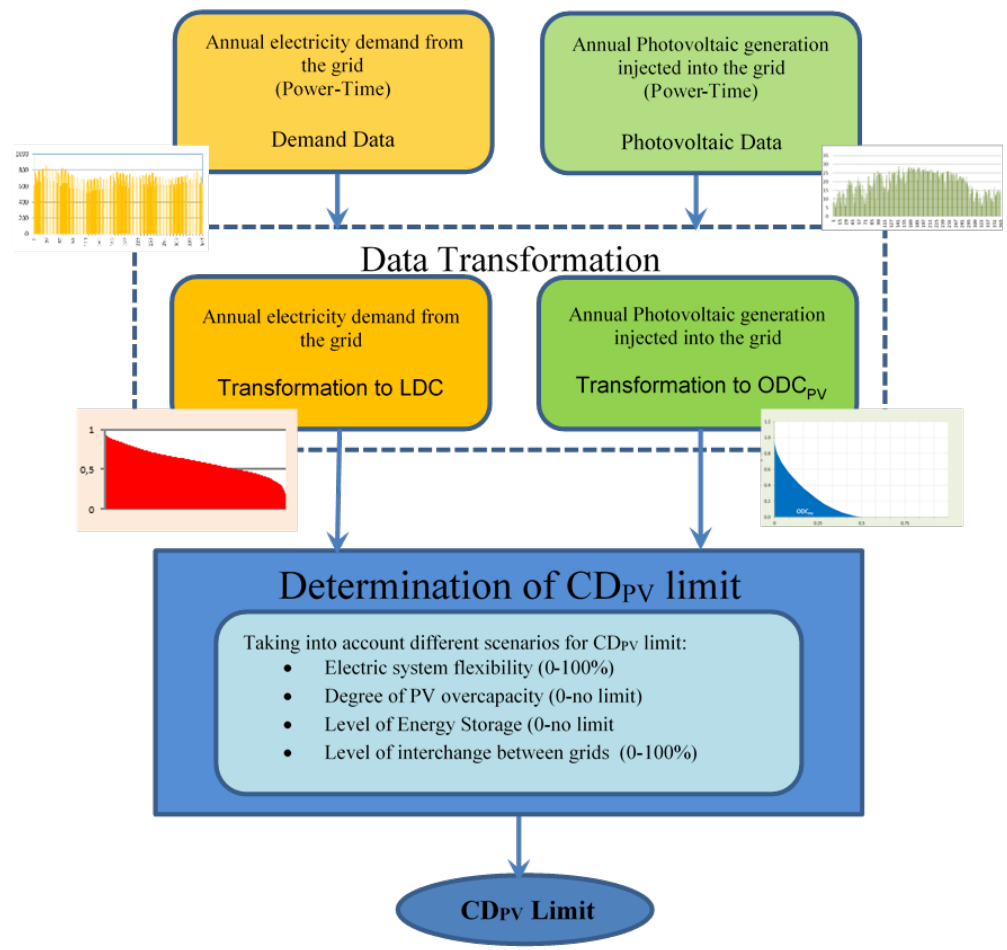
Figure 2. Proposed method for the estimation of CD PV in a large electricity grids.